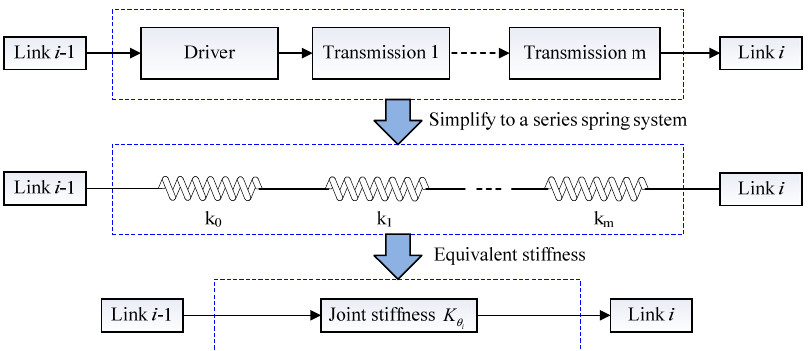
Figure 2. The conversion principle of the joint stiffness.